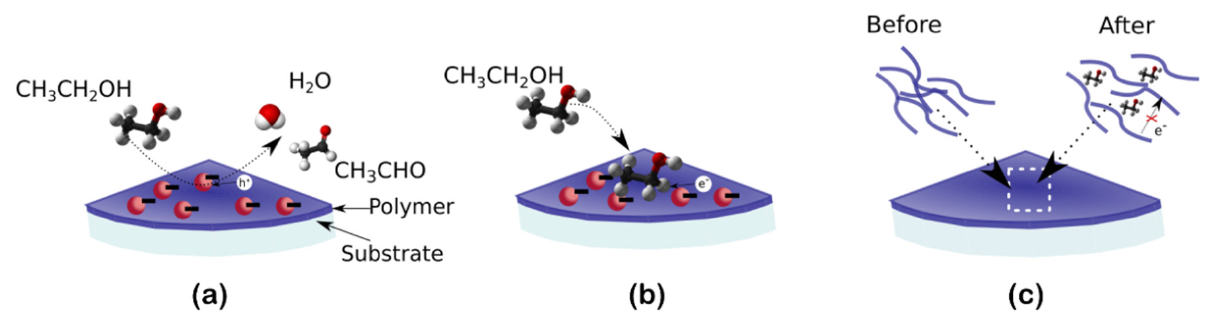
Figure 13. Different gas-sensing mechanism between a reducing analyte (ethanol) and a polymer (e.g., PEDOT:PSS) ( a ) redox reaction between the analyte and the chemisorbed oxygen on p-type materials, ( b ) direct charge transfer between the analyte and the polymer surface, and ( c ) swelling process from the diffusion of the